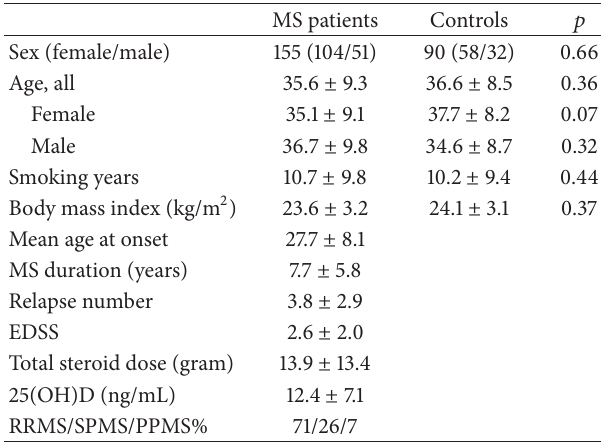
Table 1: Descriptive characteristics of MS patients and controls (mean ± SD or